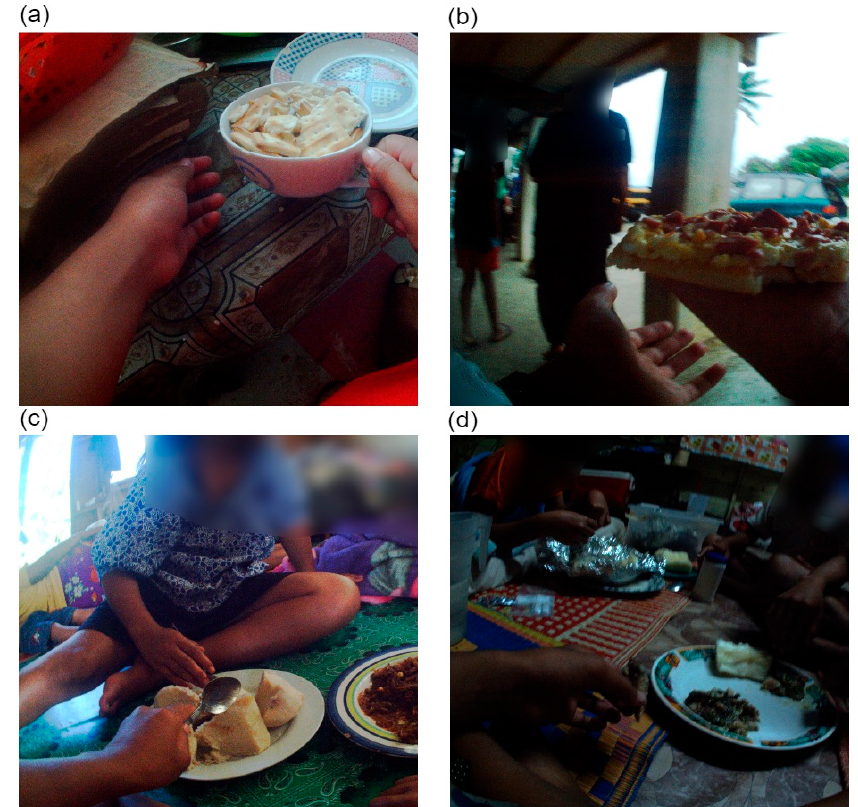
Figure 7. Non-traditional mixed meals ( a ) soaked crackers and ( b ) pizza; and traditional mixed meals ( c ) chop suey and staple vegetables, and ( d ) lu and staple vegetables.